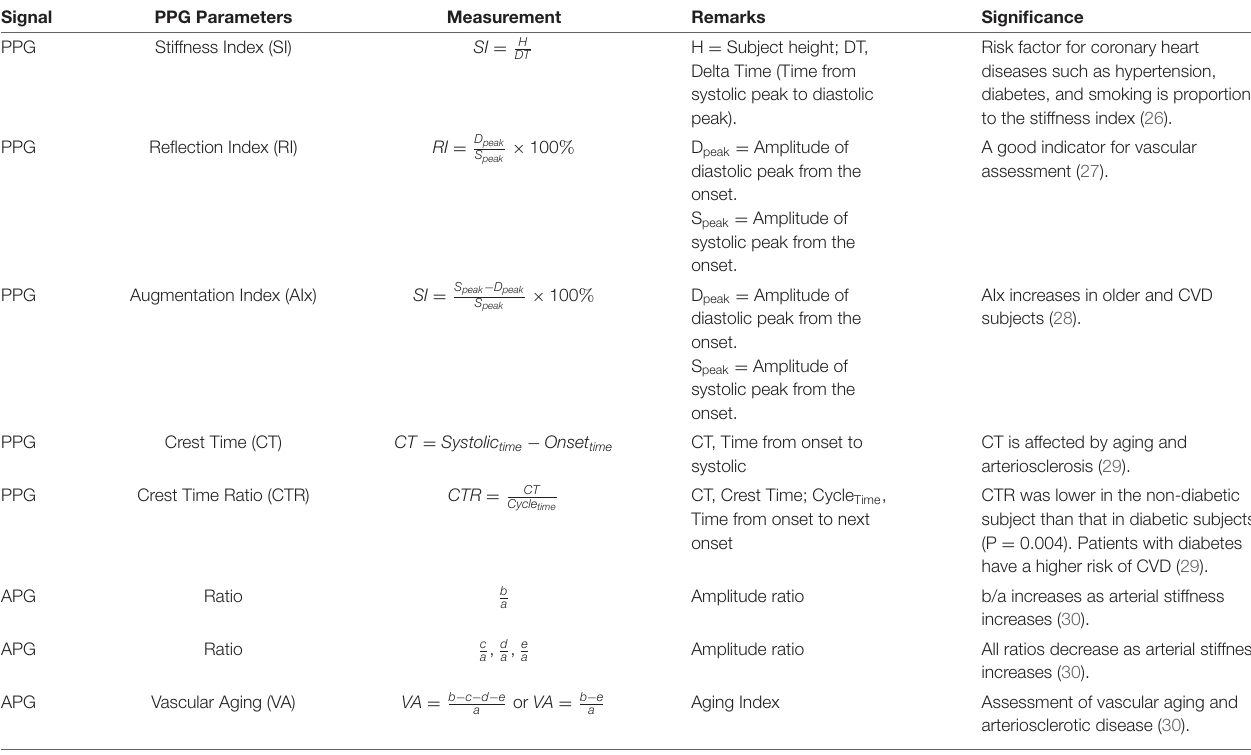
TABLE 1 | Significant CVD-related predictors based on PPG fiducial